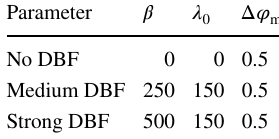
Table 2 Parameters used in the 3 types of DBF simulations in the synthetic reservoir